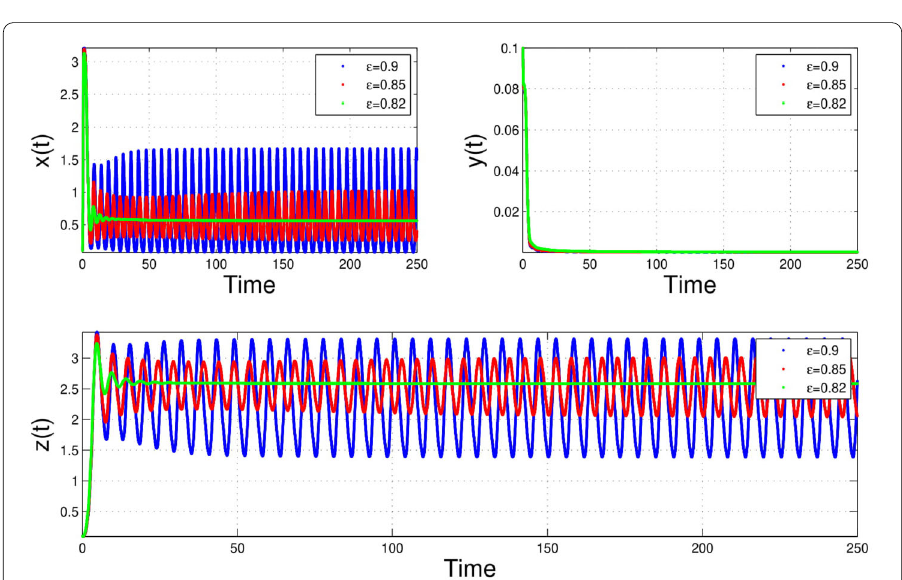
Figure 10 The influence of the memory rate on the stability of the SPFE (cid:7) 2 =